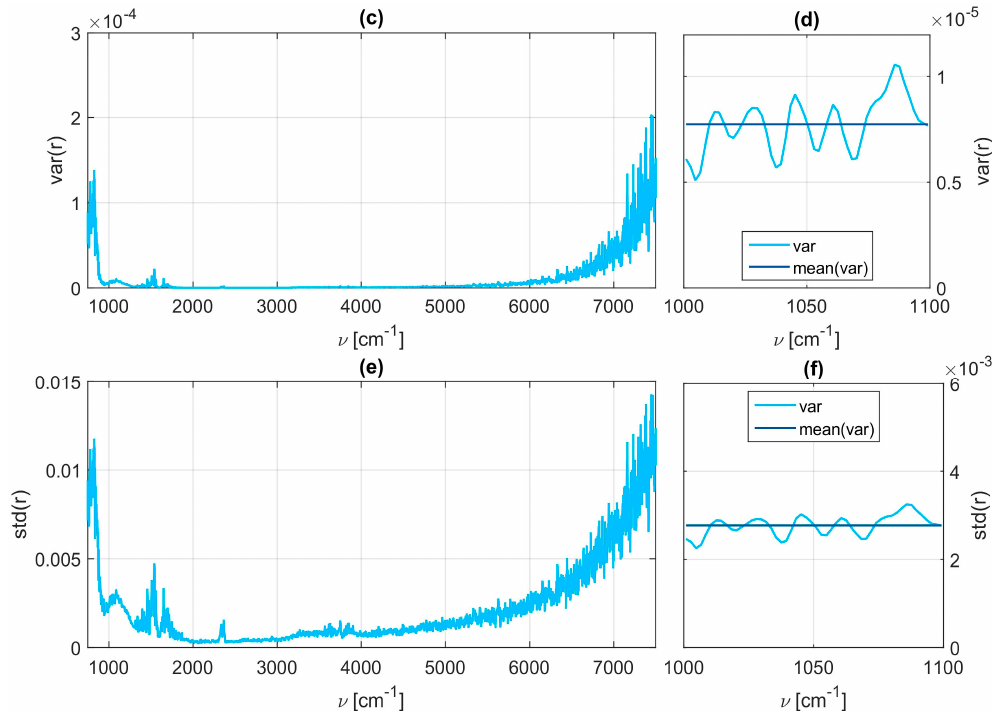
Figure A1. Statistical analysis of exemplary measurement data. The shown reflectance ( a , b ) results from a mixed solution with 50 g/l glucose and 50 g/l fructose. The measurement data consist of thirty individual spectra. The variance and the standard deviation between those spectra are calculated for each wavenumber and depicted in panels ( c , d ) and ( e , f ) respectively. The chosen measurement set reveals one of the largest variances because the reflectance of one spectra exhibits an almost constant offset. However, the qualitative features are preserved.